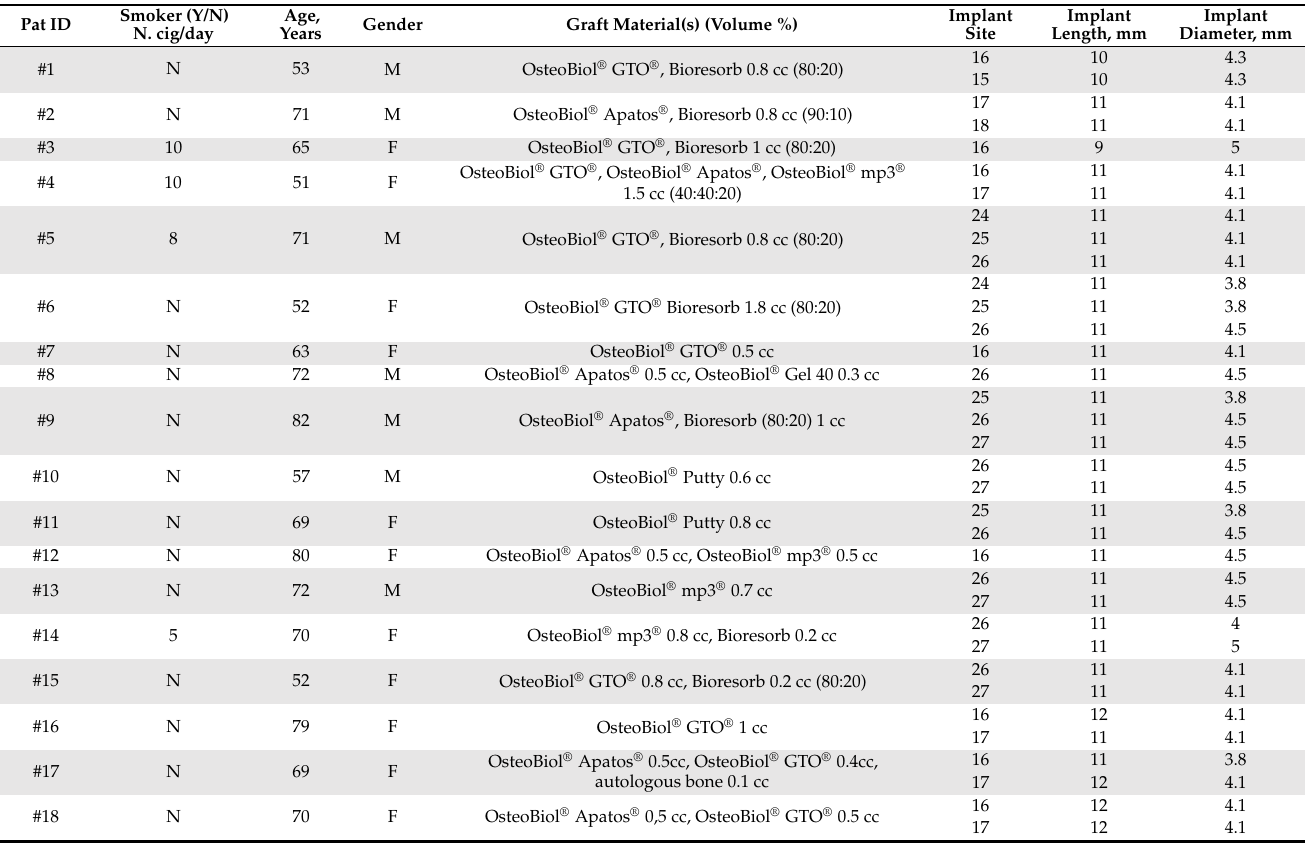
Table 1. Main features of the patients, grafts and